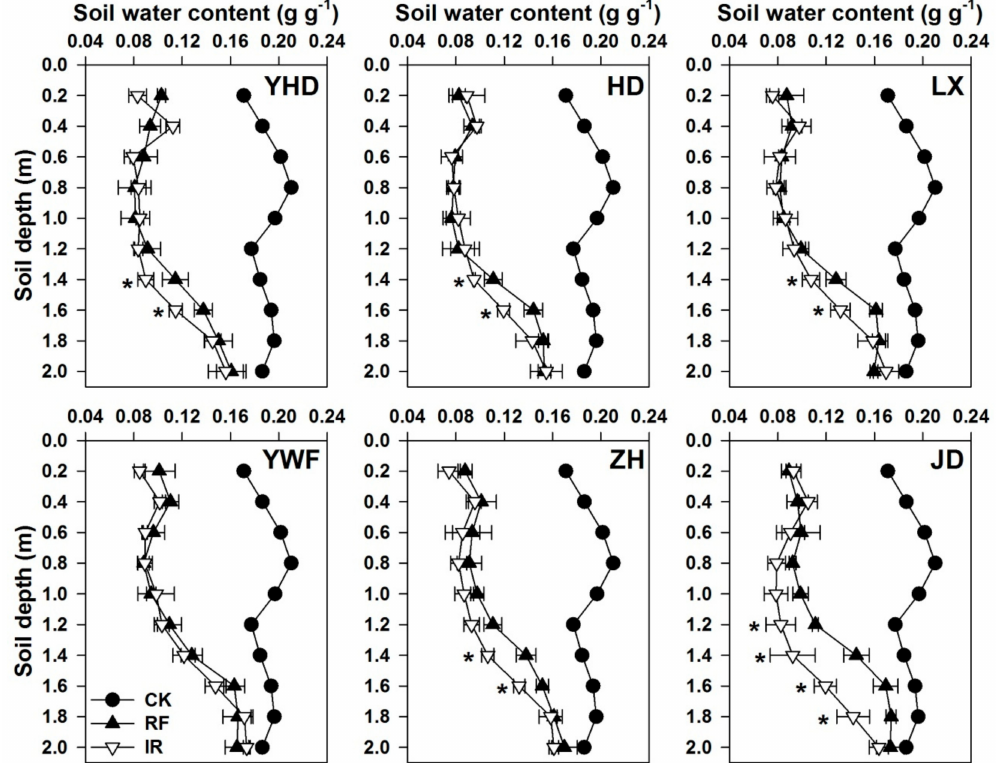
Figure 2. The soil profile of gravimetric soil water content (g g − 1 ) at 0.2 m increments in the upper 2 m of the soil profile of six soybean genotypes (four landraces: Yuanhuangdou (YHD), Huangsedadou (HD), Longxixiaohuangpi (LX) and Yiwofeng (YWF) and two recent cultivars: Jindou 19 (JD) and Zhonghuang 30 (ZH)) before sowing (CK) and at maturity under two water regimes (rainfed (RF): no water applied during flowering) and irrigated (IR): 40 mm water applied at flowering) in the field experiment in 2011. The bars indicate one standard error of the mean ( n = 3). The * indicates that the SWC was significantly di ff erent ( p = 0.05) between the IR and RF at the same soil